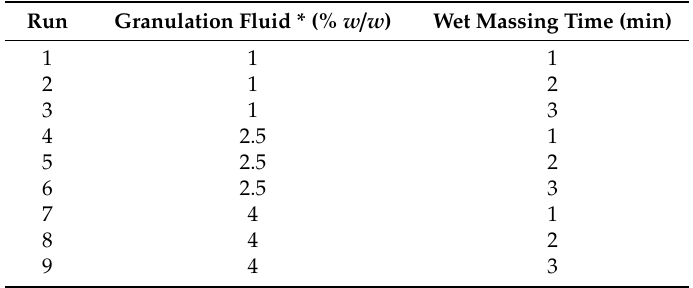
Table 9. A 3 2 full-factorial design of independent process